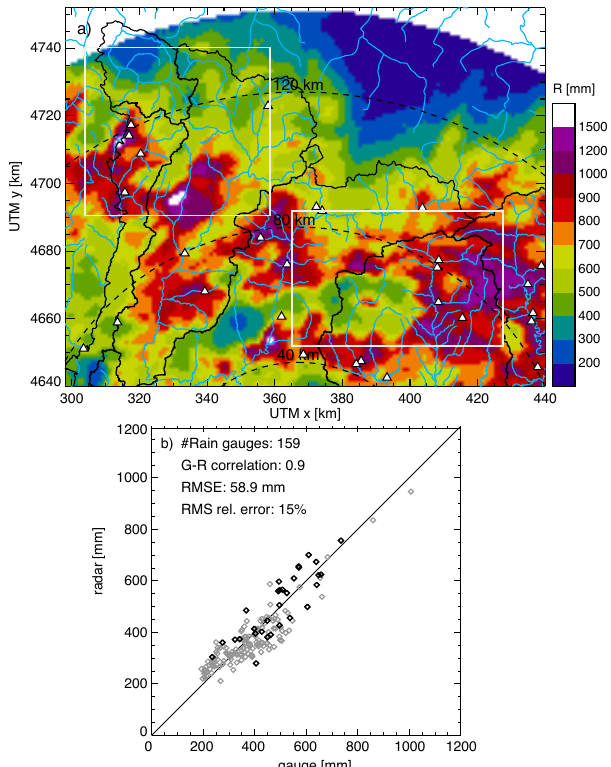
Figure 2. (a) Estimated rainfall accumulation for the period 1 May to 31 October 2010. The triangles indicate the location of the avail- able rain gauges, and the black dashed lines are at constant distances from the Creu del Vent radar (40, 80 and 120km). (b) Scatterplot of radar rain gauge accumulations over the domain of the Creu del Vent radar (the pairs over the rain gauges within the domain of Fig. 1 are shown in black).